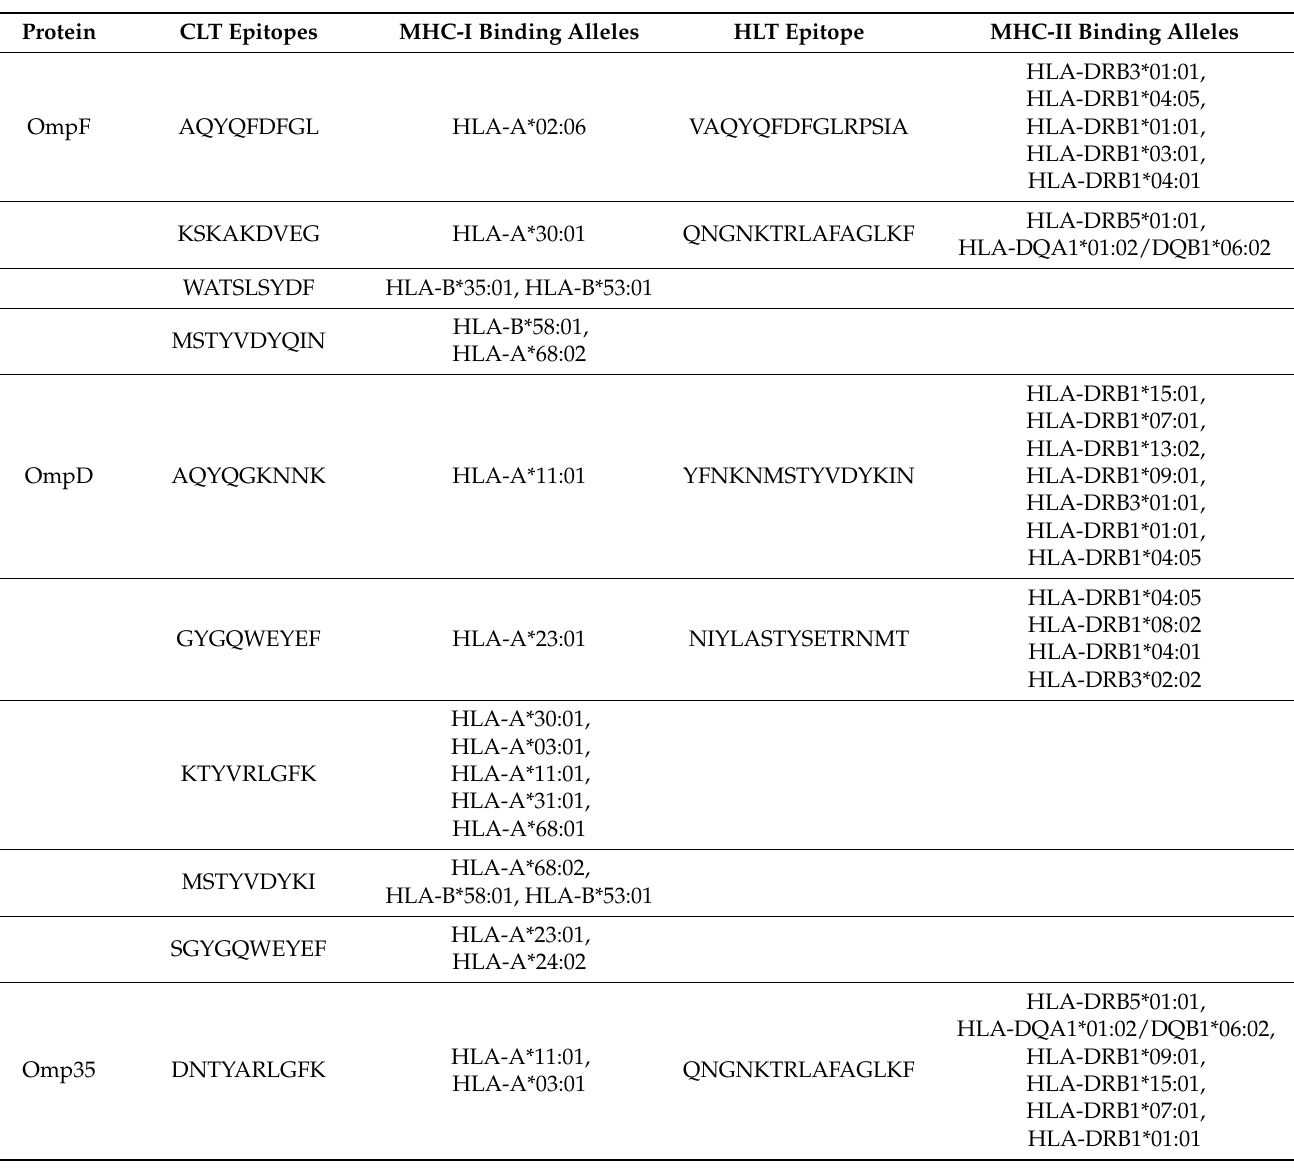
Table 3. T-lymphocytes and their associated